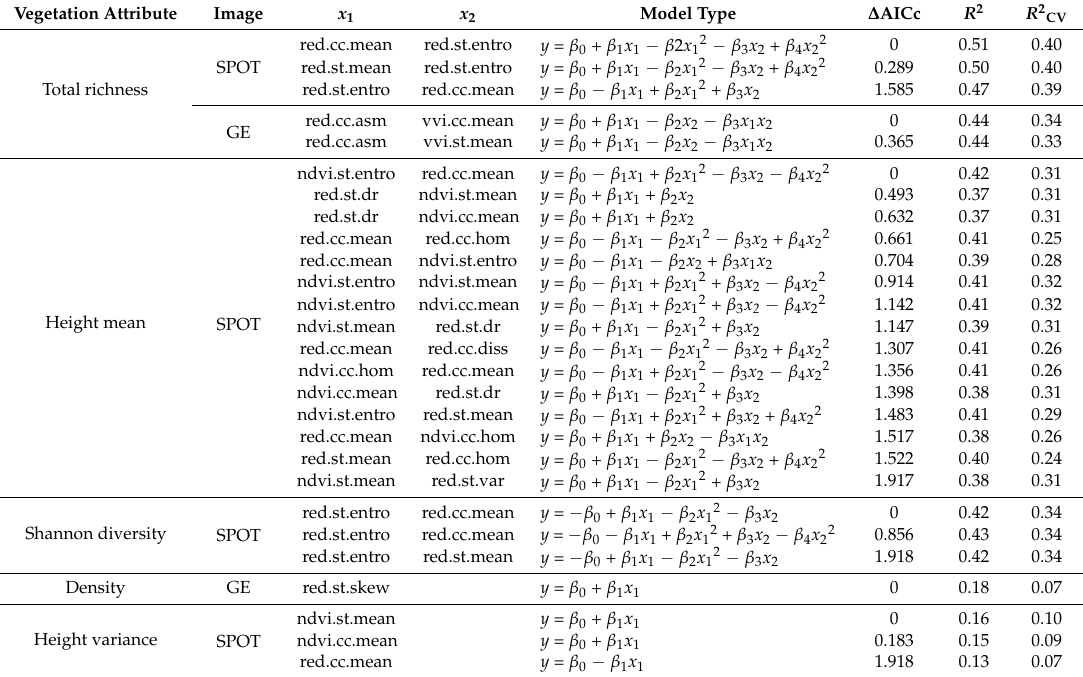
Table 2. Best models constructed for each vegetation attribute. Only those metrics for which at least one model had a p -value < 0.05 associated to its random R 2 distribution are shown. Of those, models with a Δ AICc < 2 are shown. In Model type, y is the log-transformed vegetation variable and x 1 and x 2 are the surface metrics described in their respective columns. The + and − signs indicate positive and negative β coefficients, respectively. See Supplementary Material 1 for the mathematical formulation of surface metrics.